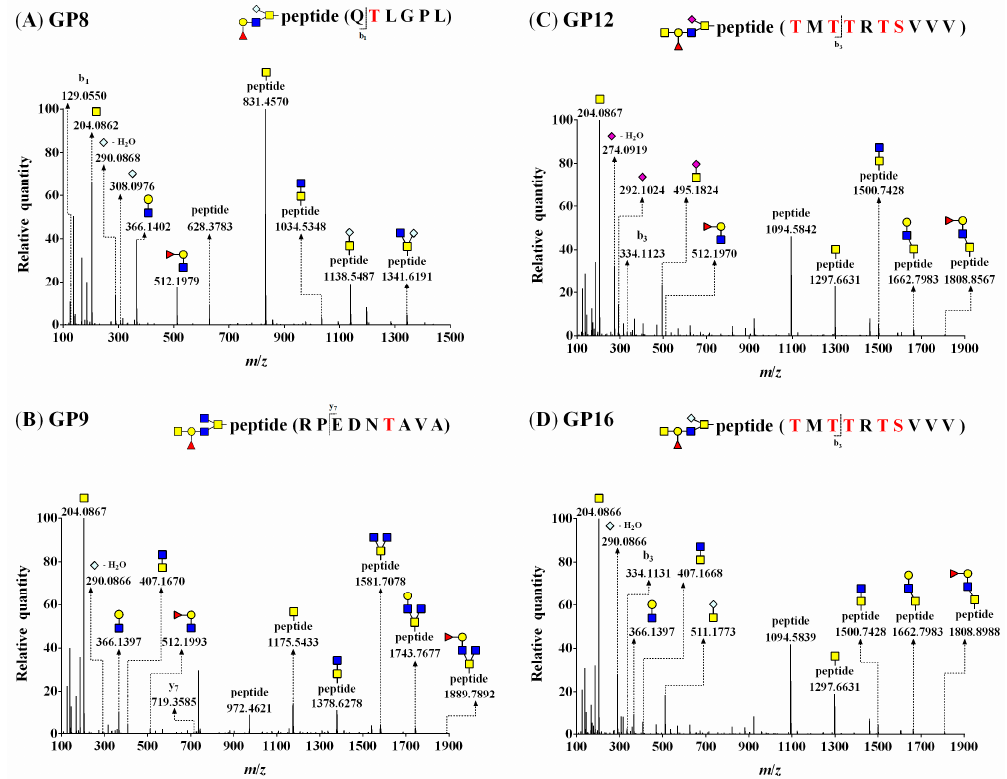
Figure 3. HCD–MS / MS spectra of ( A ) GP8 (G21 attached to QTLGPL, theoretical m / z = 825.3668), ( B ) GP9 (G19 attached to RPEDNTAVA, theoretical m / z = 1046.9550), ( C ) GP12 (G24 attached to TMTTRTSVVV, theoretical m / z = 1152.0195), and ( D ) GP16 (G33 attached to TMTTRTSVVV, theoretical m / z = 1160.0169) O -glycopeptides. All glycopeptide masses were observed as doubly charged forms, and the precursor ions of O -glycopeptides are shown in the MS spectra with full scan mode in Figure S2. A red S or T indicates an O -glycosylation site of BSM. (cid:4) , GlcNAc; (cid:4) , GalNAc; • , Gal; (cid:78) , Fuc; (cid:95) , Neu5Ac; ♦ , Neu5Gc.